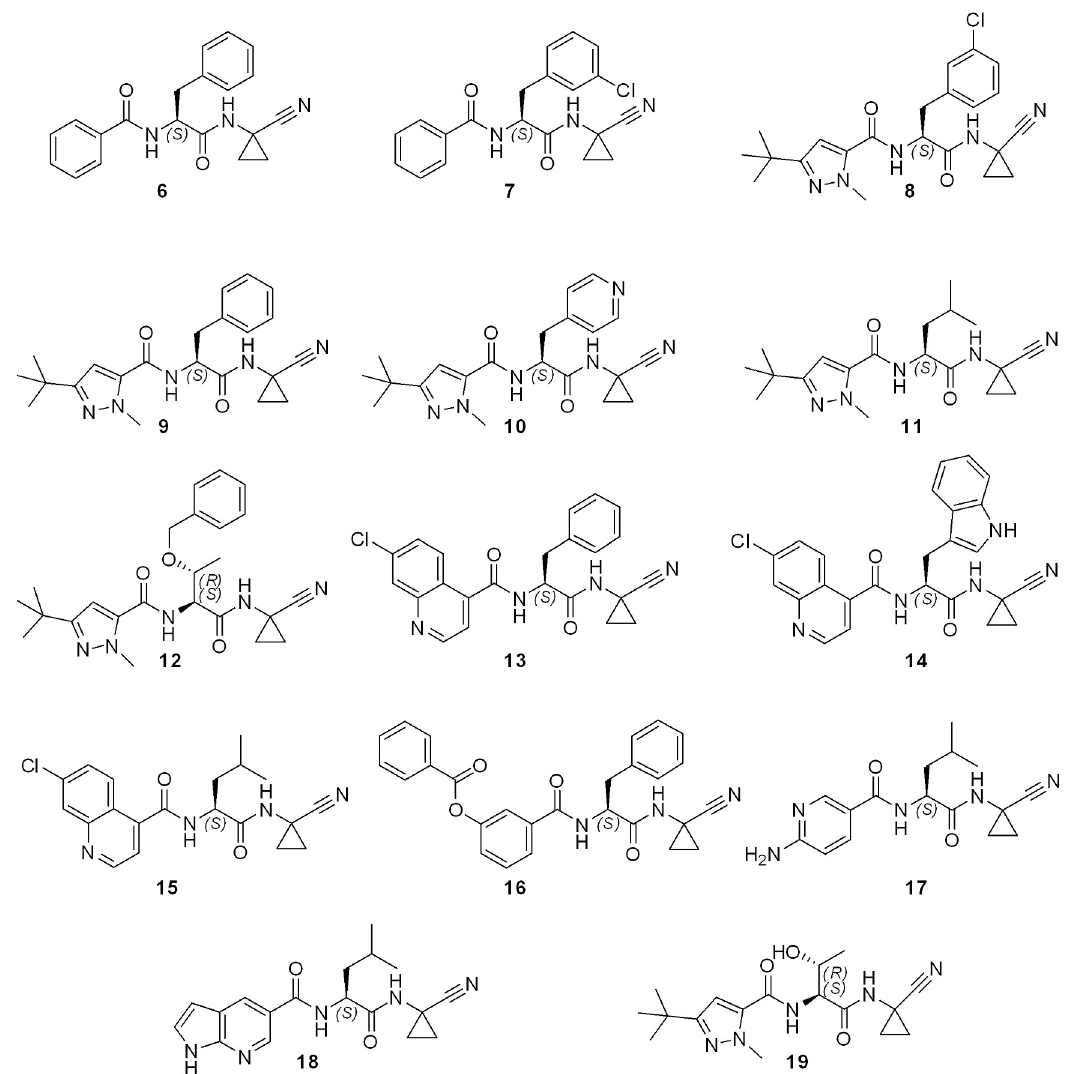
Fig 5. Structure representation of compounds